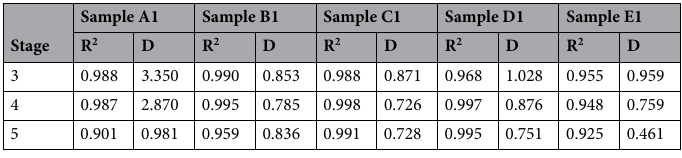
Table 4. The R 2 and D for different phases of